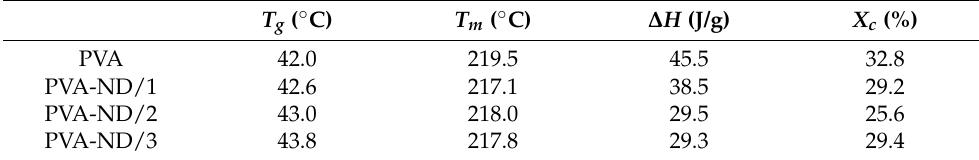
Table 3. T g , ∆ H, and X c of the pure PVA film and the PVA in the PVA-ND nanocomposites. T g ( ◦ C) T m ( ◦ C) ∆ H (J/g) X c (%)